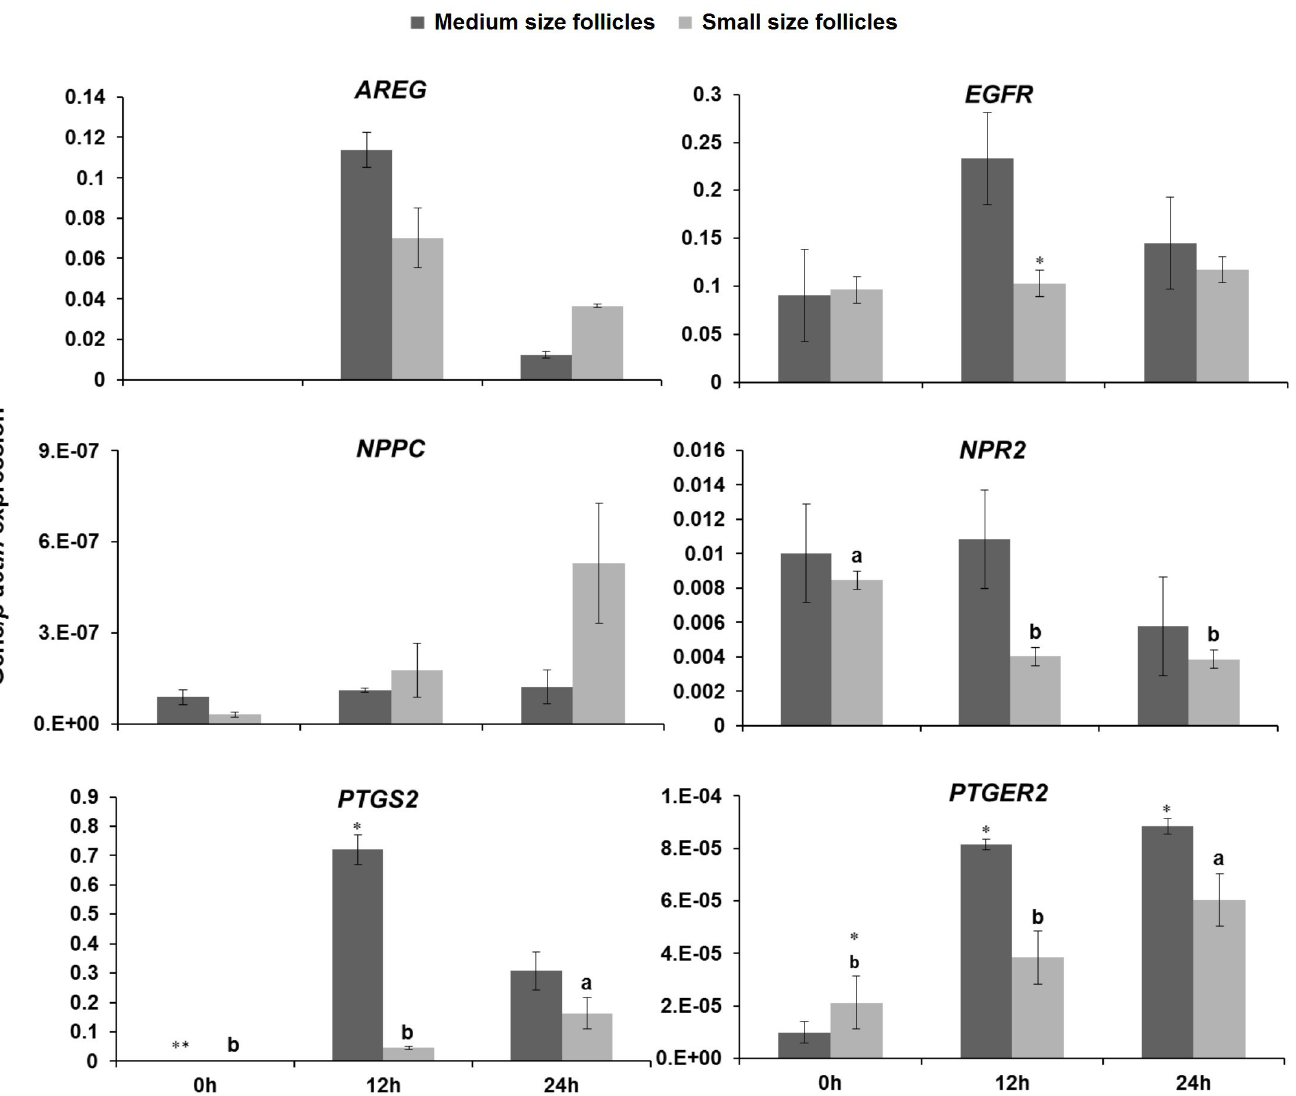
Fig 3. Gene expression of AREG , EGFR , NPPC , NPR2 , PGE2 , and PTGS2 between cumulus cells derived from medium ( > 4 to 6 mm) and small (2 to � 4 mm) size follicles at 0, 12 and 24 h post- in vitro maturation in a conventional medium. 3 replicates and minimum number of cumulus cells in each replicate were 2 × 10 5 . Different superscripts demonstrate significant differences (P < 0.05) within columns with the same color. The asterisks represent significant differences between the two groups at the same time of maturation. 2 ^-(delta CT) was presented for gene expression. AREG : amphiregulin, NPPC : natriuretic peptide precursor C, PTGS2 : prostaglandin-endoperoxide synthase 2, EGFR : epidermal growth factor receptor, NPR2 : natriuretic peptide receptor B, PGE2 : prostaglandin E synthase